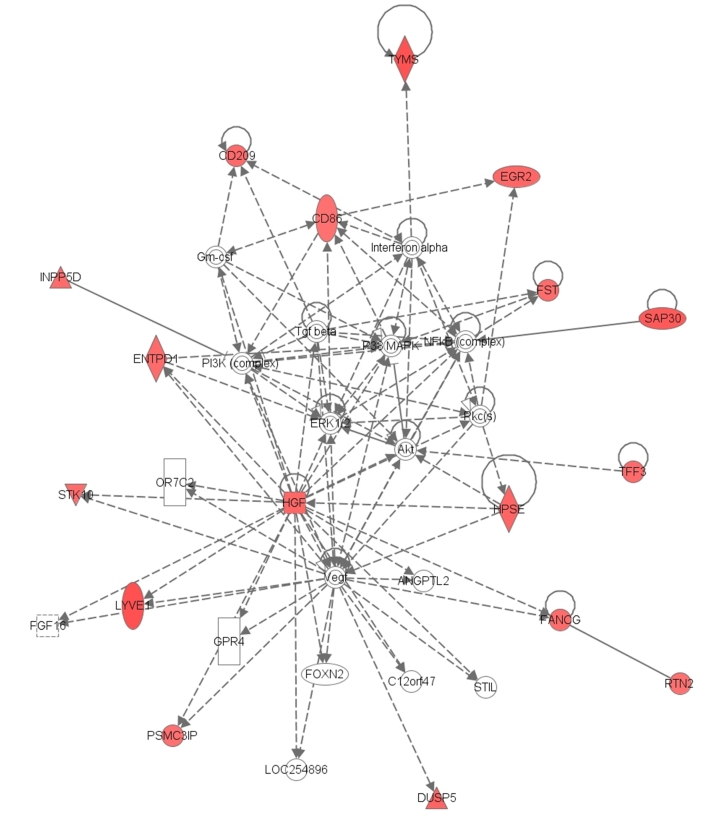
Top scoring network of differentially expressed genes between CSP and PPP kidneys.The top-scoring network of interactions among the probe sets identified as significantly differentially expressed when comparing CSP vs. PPP kidneys. The probe sets were subsequently analyzed using the Ingenuity Pathway Analysis software (https://analysis.ingenuity.com). This software is designed to identify dynamically generated biological networks, global canonical pathways and global functions. Interconnection of significant functional networks, where molecule nodes in different shades of red and green or white depending on being up-regulated and down-regulated or no-change, respectively, in CSP samples.